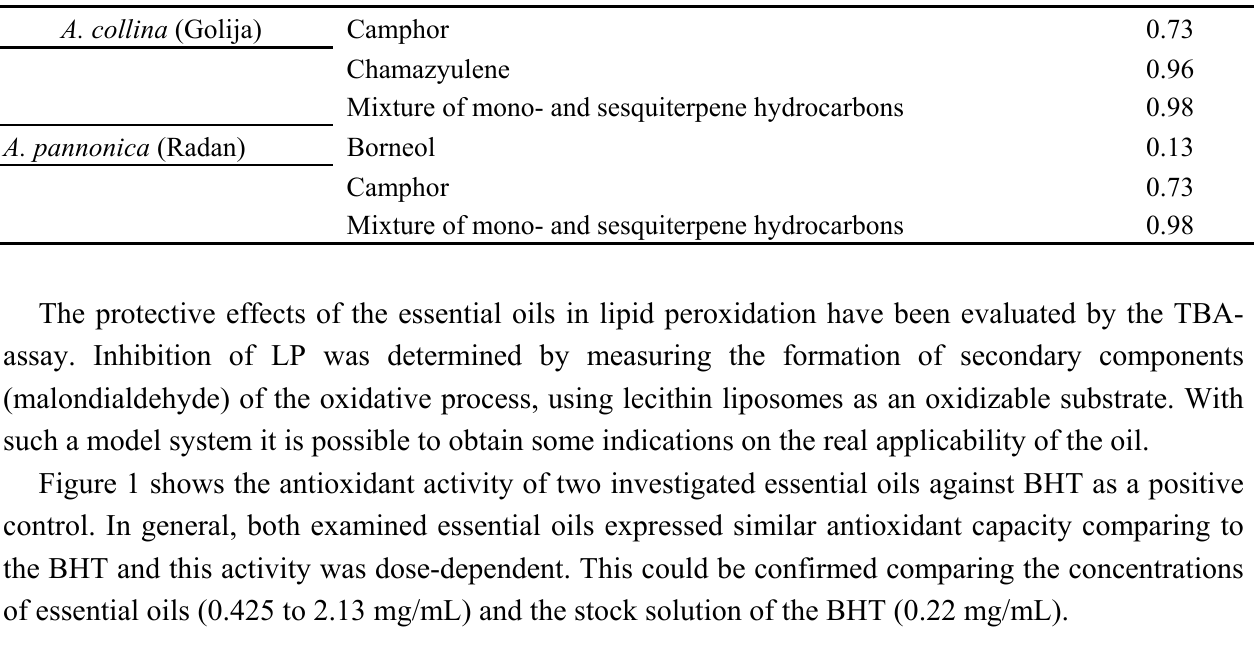
Table 2b . DPPH scavenging active compounds identified by TLC dot-blot technique. Source of essential oil